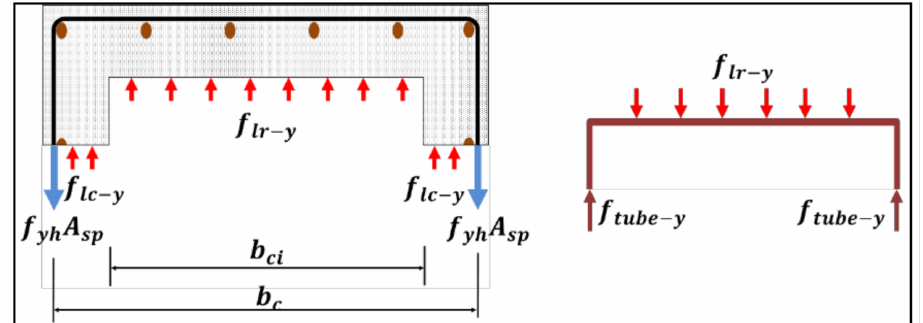
Figure 4. Confining stress on concrete in an ICH RC column in y-direction: ( left ) FBD for concrete and reinforcement; ( right ) FBD for internal